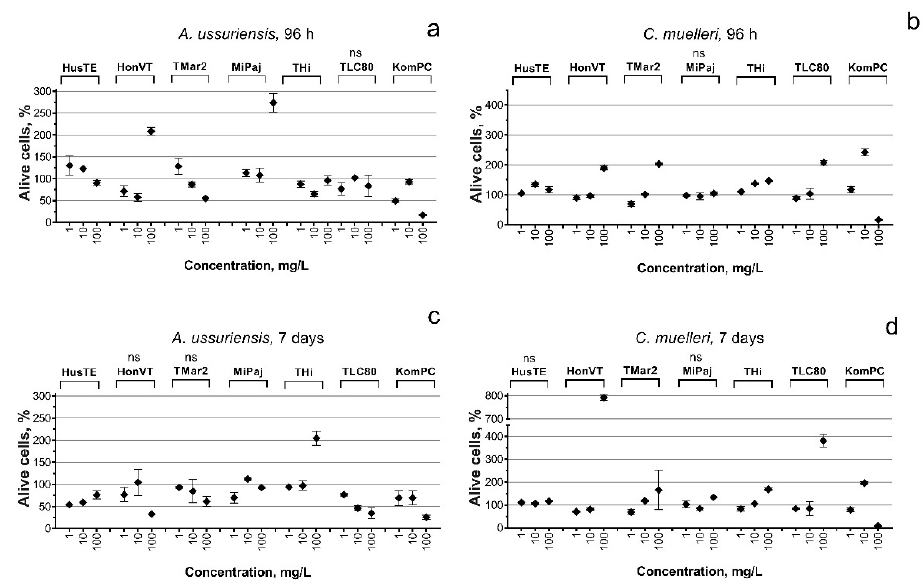
Figure 2. The influence of VEP samples on the microalgae growth rate: ( a ) A. ussuriensis after 96 h of exposure; ( b ) C. muelleri after 96 h of exposure; ( c ) A. ussuriensis after 7 days of exposure; ( d ) C. muelleri after 7 days of exposure; ns, the tested sample had no significant effect on the growth rate of microalgae ( p > 0.05). The series without the mark “ns” significantly influenced the growth rate of the microalgae ( p <